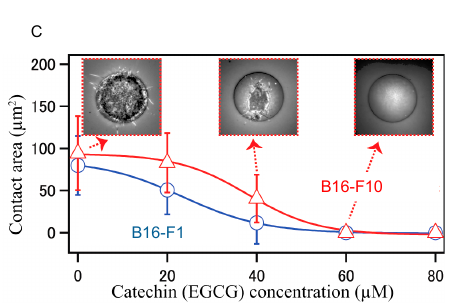
Figure 5. Treatment with EGCG reduced adhesion of low metastatic (B16-F1) and high metastatic (B16-F10) cells. ( A ) Bright field and RICM image show adhesion of B16-F1 and B16-F10 cells on the spot of cell-adhesive SAM substrate. The red area (A χ = 0.48) shows the tight contact area calculated; ( B ) Bright field and RICM image of B16-F1 and B16-F10 cells treated with 20 μ M EGCG; ( C ) Dose-dependent reduction of tight contact area in B16-F1 (blue line) and B16-F10 (red line) cells by treatment with EGCG. Reprinted with permission from American Chemical Society [71].